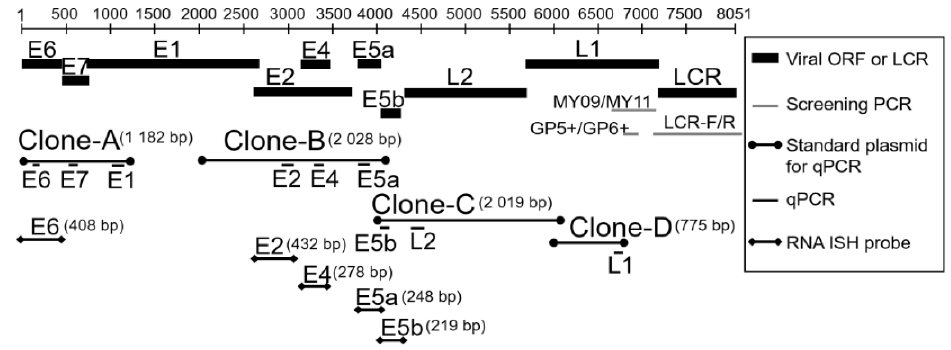
Figure 1. Schema of human papillomavirus-6 (HPV-6) genes and information of plasmid clones and RNA in situ hybridization probes used in this study.